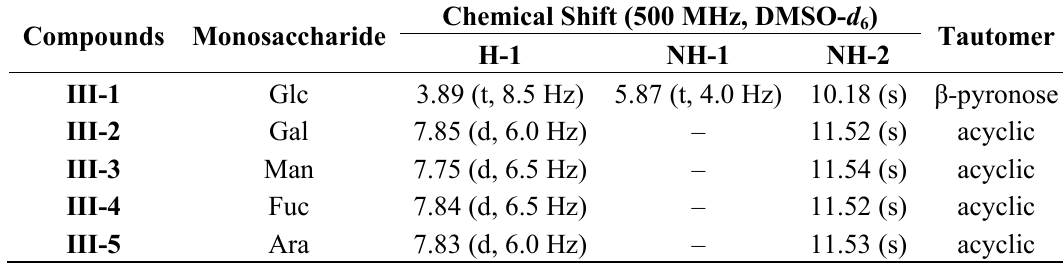
Table 1. 1 H NMR spectra data of the condensation products of 5-(4'-chlorophenyl)-2-furoyl hydrazide with different